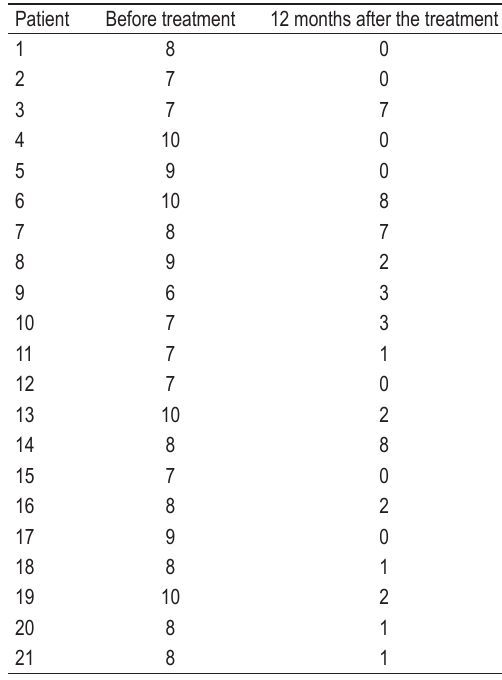
TABLE 4. VAS (0‑10) score before and 12 months after the treatment with Prolotherapy Patient Before